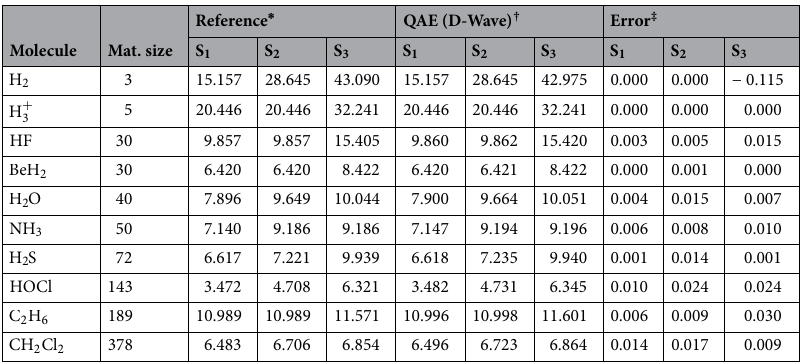
Table 1. Singlet TDDFT excitation energies (eV). ∗ Reference calculation on CPU using unmodified PySCF. † PySCF was modified to use the QAE and D-Wave 2000Q. ‡ Difference between the two types of calculation.